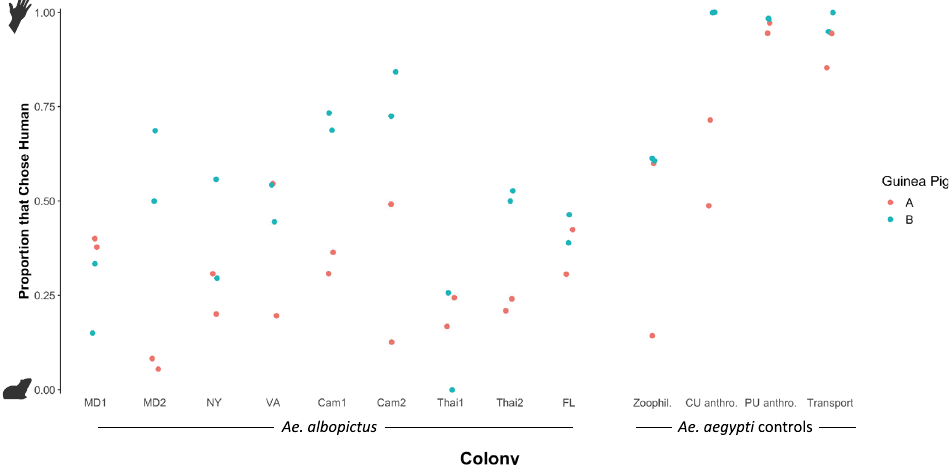
Figure 3. Scatter plot of the proportion of host-seeking mosquito that chose human over guinea pig for each of the colonies, with the color representing the guinea pig. Each point represents the results of one replicate in the second